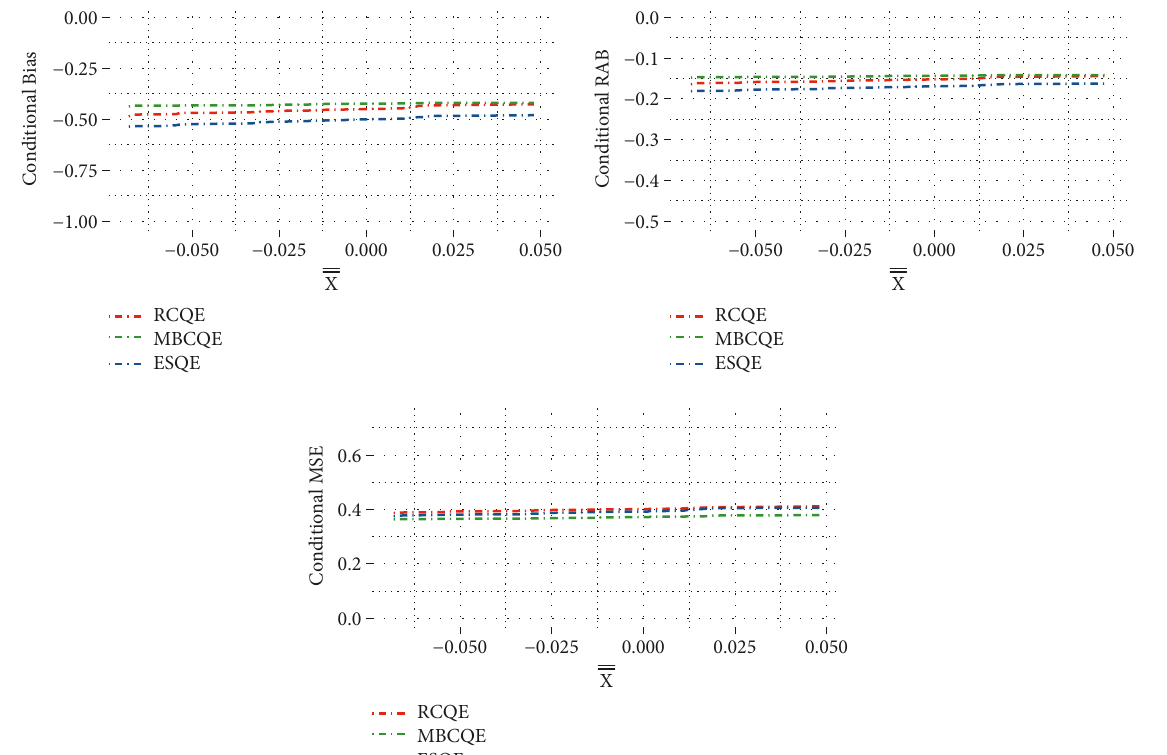
Figure 5: CB, CRAB, and CMSE for estimators: cosine mean function, α � 0 . 5.